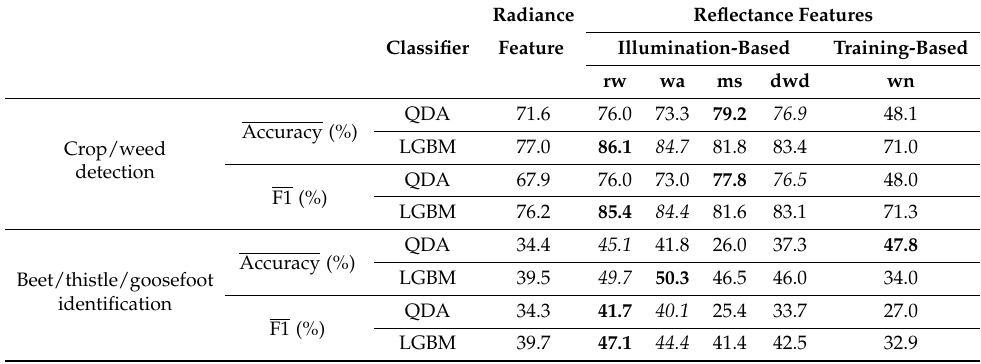
Table 3. Crop/weed detection and beet/thistle/goosefoot identification results with the QDA and LGBM classifiers. Bold shows best result and italics second best